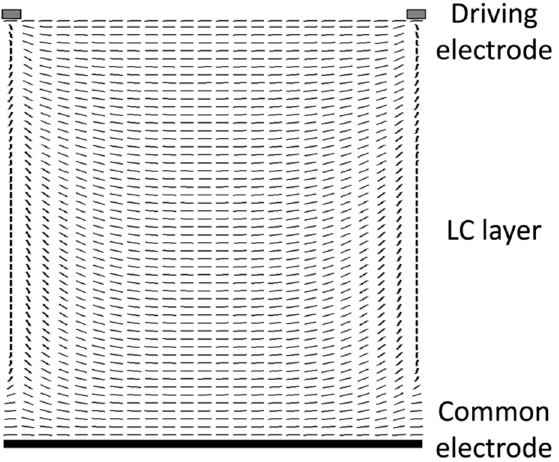
Figure 4. LC directors in a cross section of the ELC diffusing unit under the optimum conditions obtained by Taguchi’s method.